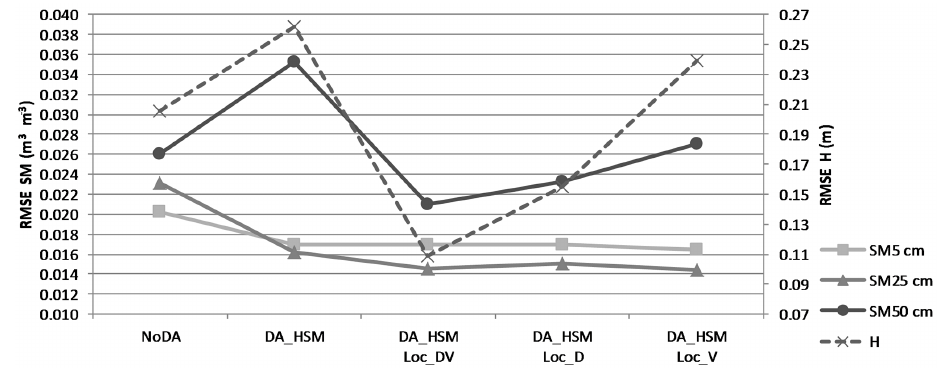
Figure 5. Spatially and temporally averaged RMSE of groundwater head and soil moisture at different depths for each multivariate assimi- lation experiment in the Karup catchment. The left axis represents soil moisture and the right axis